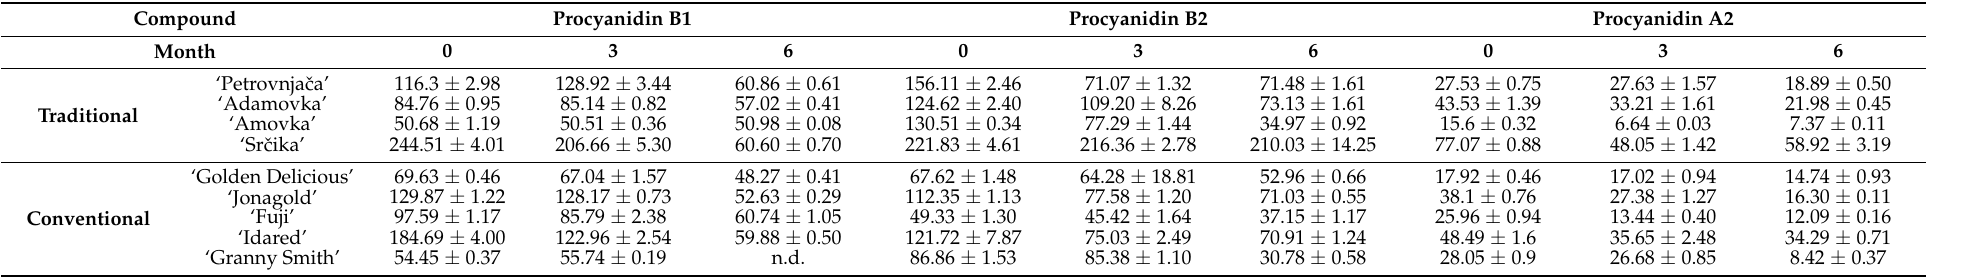
Table 4. The content of procyanidins ( µ g/g dw a ) in the traditional and conventional apple cultivars.